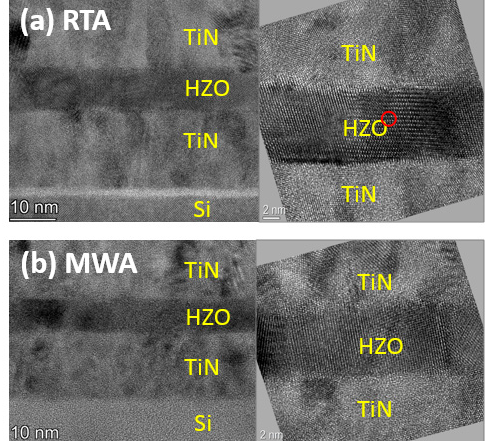
Figure 3. The cross-sectional TEM images with measured lattice distances of the ( a ) RTA and ( b ) MWA samples. The circled region in the RTA sample denotes discoloration.